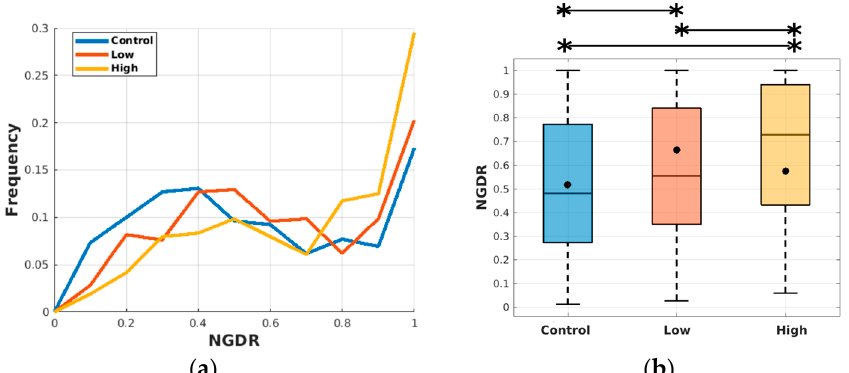
Figure 5. NGDR of T. turbinata in the control group (with I. galbana only) and under MP addition at 100 (Low) and 1,000 beads mL − 1 (High). MP treatments contained I. galbana at the same concentration as in the control group. Copepods were observed after being transferred to filtered seawater. ( a ): frequency distribution. ( b ): mean NGDR, and lower and upper limits. Horizontal bars on the top of the right panel represent statistical differences between groups.